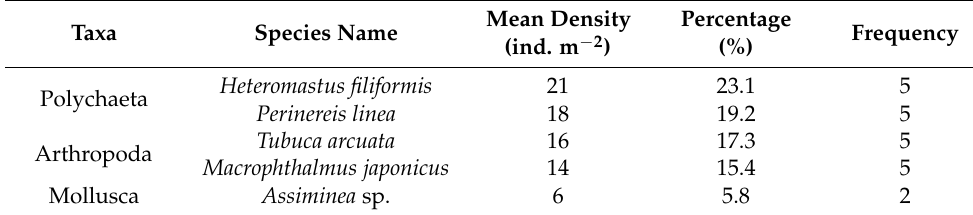
Table 4. Dominant species of macrobenthos collected from the tidal flat of the Yubu Island in the western coastal area of South Korea.